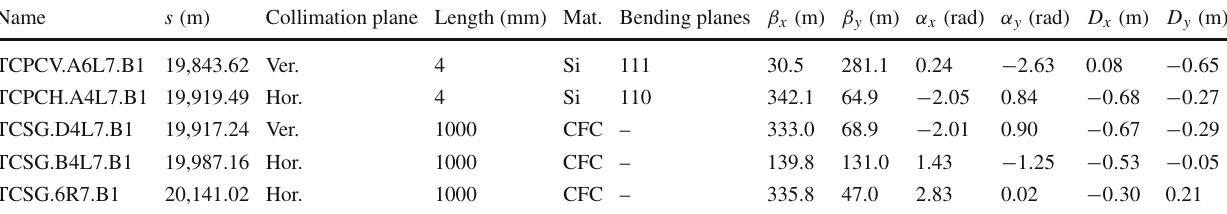
are used. Longitudinal installation positions are measured from the first LHC collision point. The position of the middle point of the collimation insertion, IP7, is at 19994.16 m